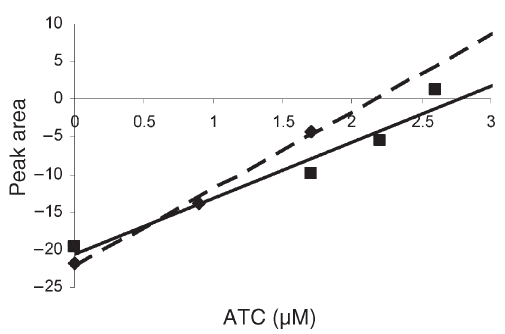
Figure 3. Plot of a series of Hummel-Dreyer protein elution profiles. Trough or peak area was plotted against the aspartate carbamoyl- transferase (ATC) concentration. A Superose 12 column was equili- brated with 1.7 µM ATC in 20 mM Tris-HCl, pH 8.0, 100 mM NaCl. Samplescontaining5 ( (cid:2) ) and 10 µM carbamatekinase (CK) ( (cid:2) ) and various ATC concentrations (0, 0.9 and 1.7 µM ATC with 5 µM carbamate kinase (CK), and 0, 1.7, 2.2 and 2.6 µM ATC with 10 µM CK were applied to the